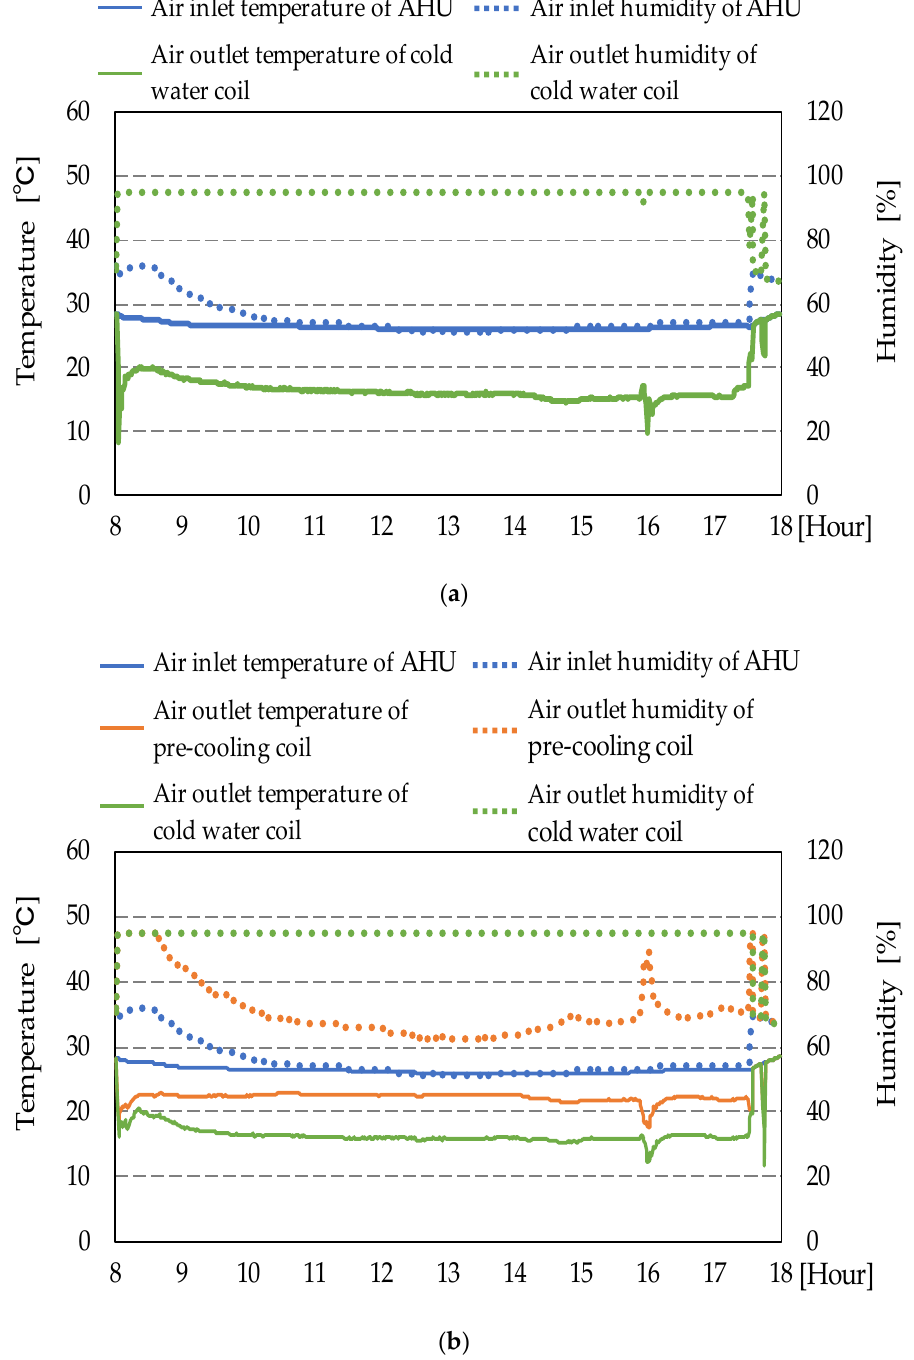
Figure 11. Air temperature and humidity before and after the AHU by the cooling operation. ( a ) Cold water coil operation (Case ATES-C1-7). ( b ) Pre-cooling coil operation (Case ATES-C2-14).